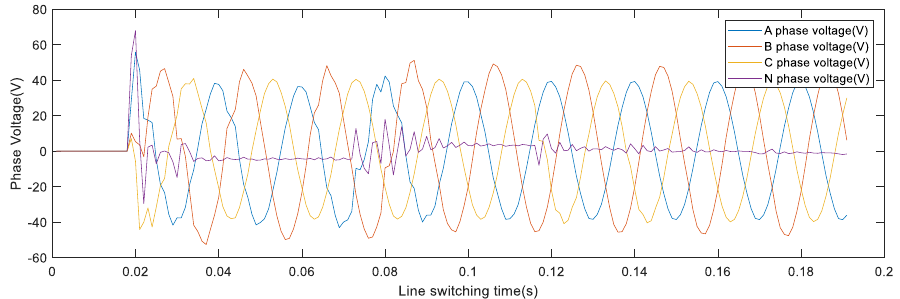
Figure 8. Transient voltage fluctuation of A, B, C, and N in line disconnected.